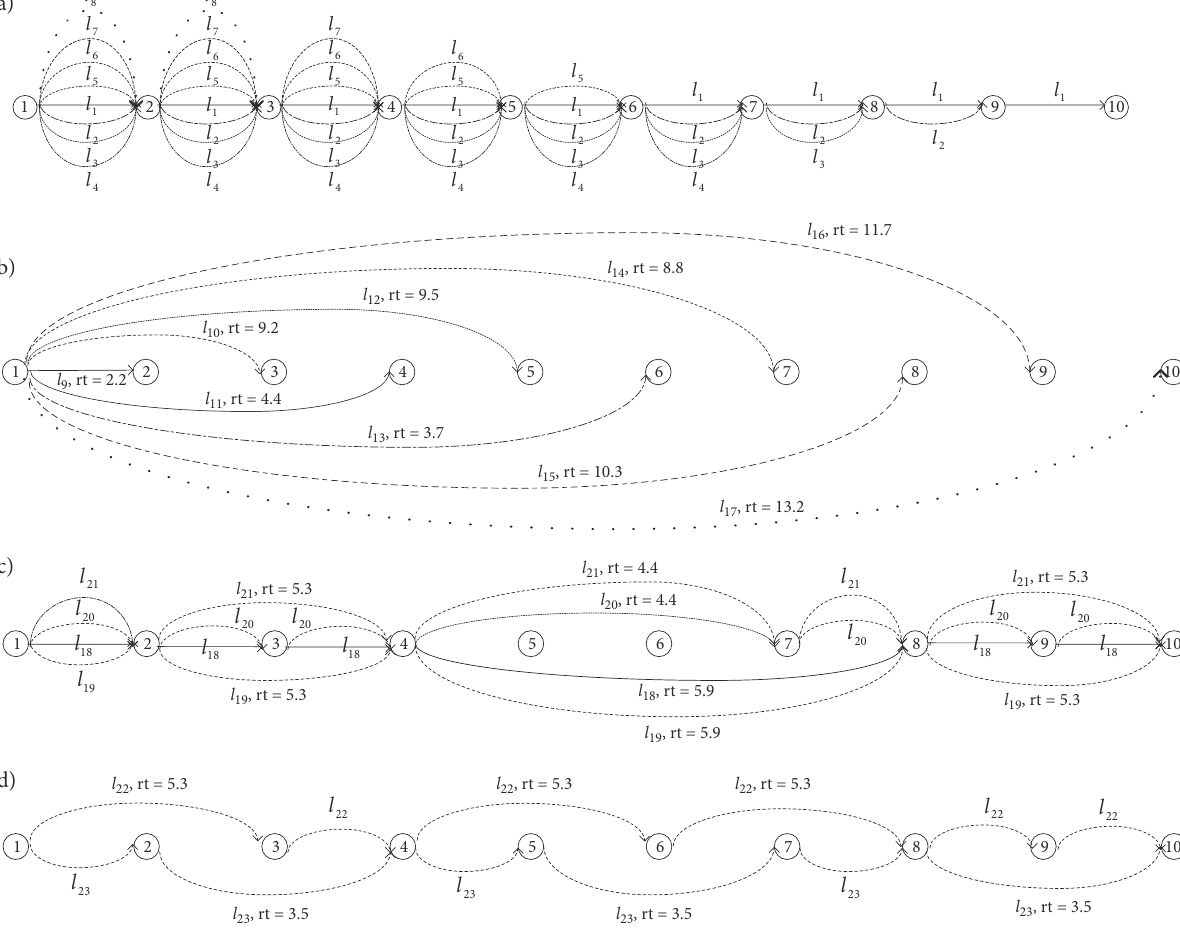
Figure 2. A corridor scenario (source: Leiva et al. 2010): a – normal services (short-turn and full-length); b – express services; c – limited-stop services Table 2. O–D trip demand matrix on the bus corridor (source: Tirachini